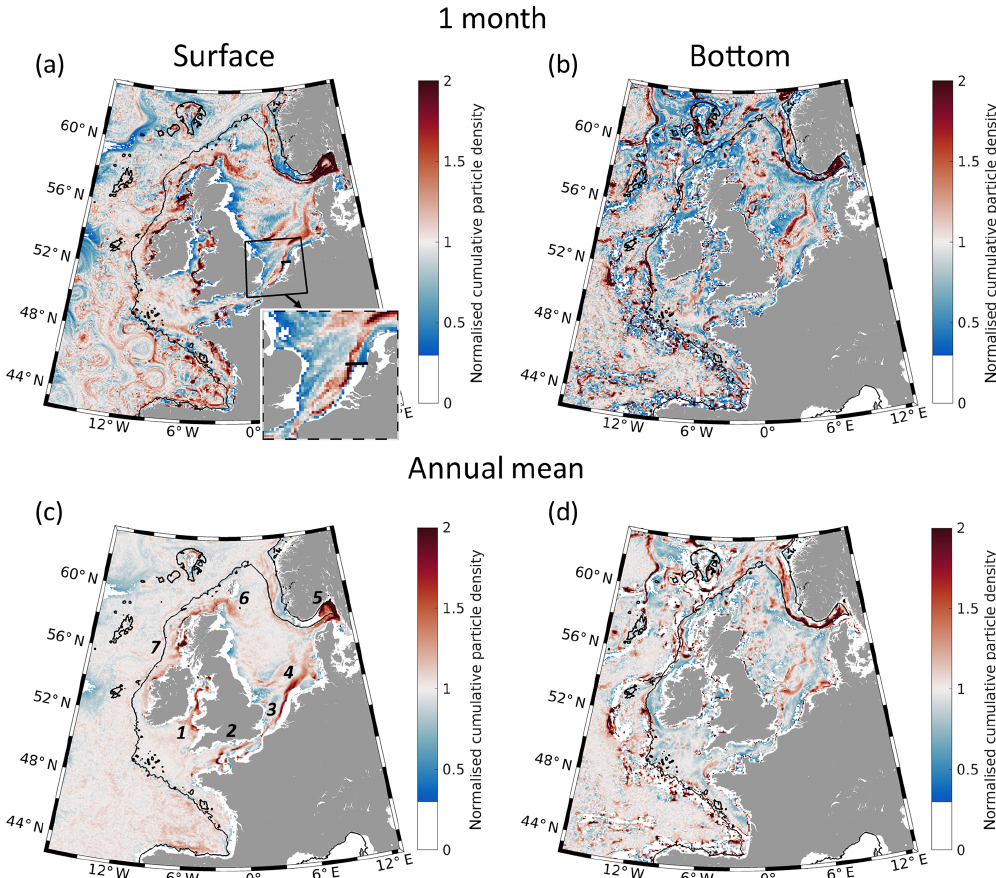
Figure 5. Tendencies of accumulation shown as (a, b) the January mean normalised cumulative particle density (NCPD) and (c, d) the average of monthly NCPD for 2015 (averages of Figs. S5 and S6, respectively) in the control run (CR, no. 1; see Table 1). Panels (a) and (c) correspond to surface-released particles, while panels (b) and (d) correspond to bottom-released particles. In (a) , the solid black line located in the Southern Bight is the transect shown in Fig. 7 (enlarged in the inset). The numbers in (c) indicate the most pronounced accumulation